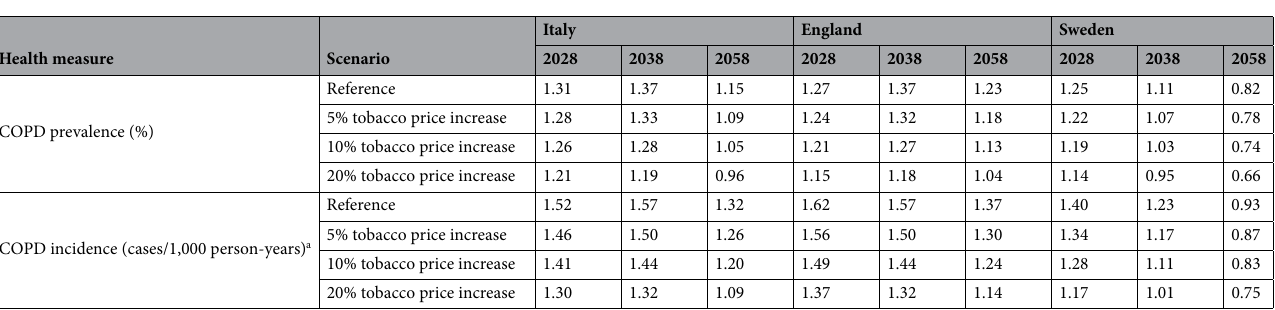
Table 2. COPD burden (prevalence and incidence) 10 (2028), 20 (2038) and 40 (2058) years from the implementation of the intervention. Results reported per country and scenario. a The COPD incidence value after 39 years (2057) instead of 40 years (2058) is given as DYNAMO does not calculate COPD incidence rates for the last year of the